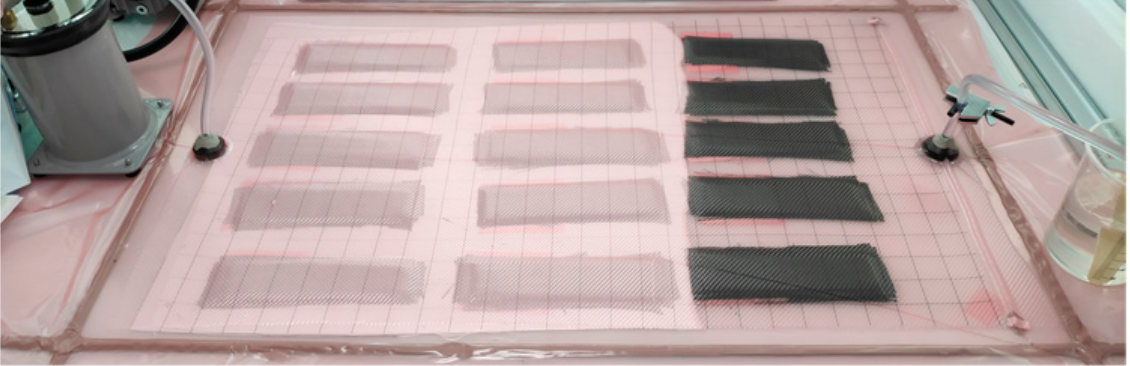
Figure 1. Photo of the vacuum assisted resin transfer molding process (VARTM).